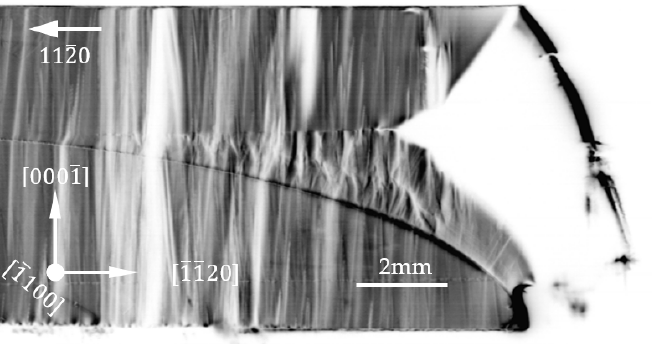
Figure A1. X-ray topograph of the (12(cid:3364)10) slice imaged using the 3(cid:3364)030 reflection (Mo-K α 1 radia- tion).